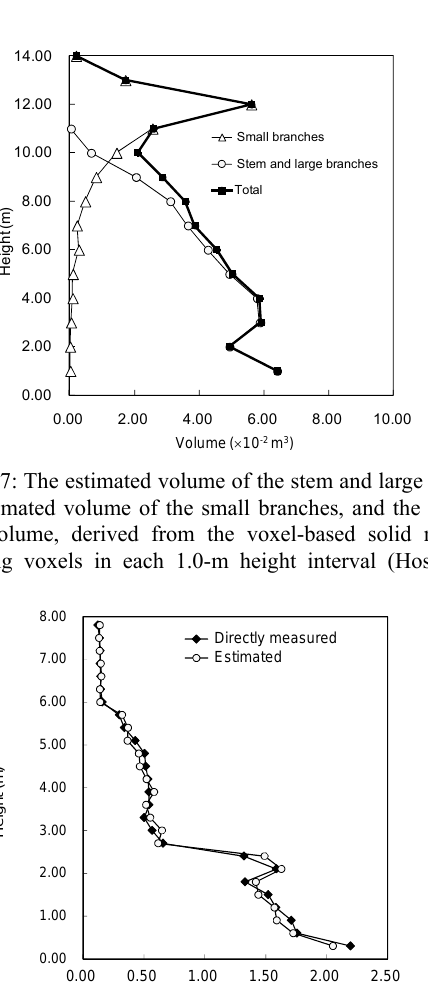
Figure 8: Comparison of the woody material volume of a certain part of the target tree estimated from the voxel solid model and the directly measured volume for each 0.30-m height interval (modified from Hosoi et al.,